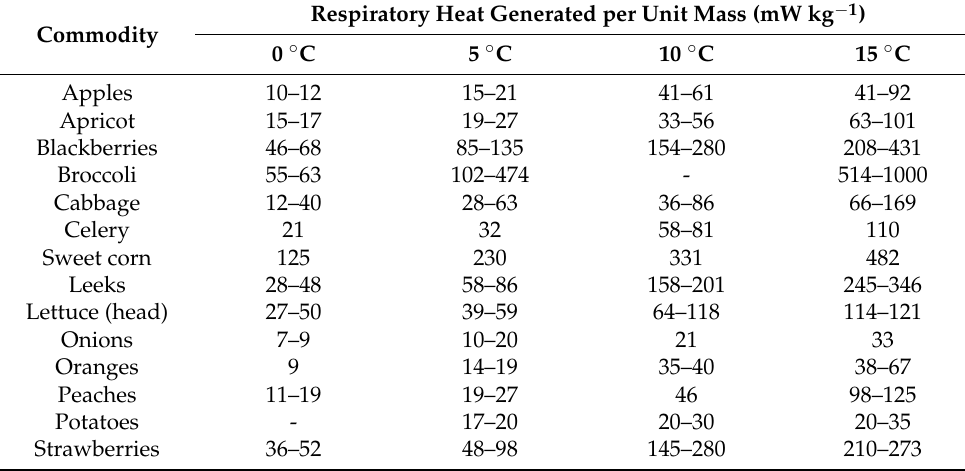
Table 3. Respiration heat of selected fruit and vegetables